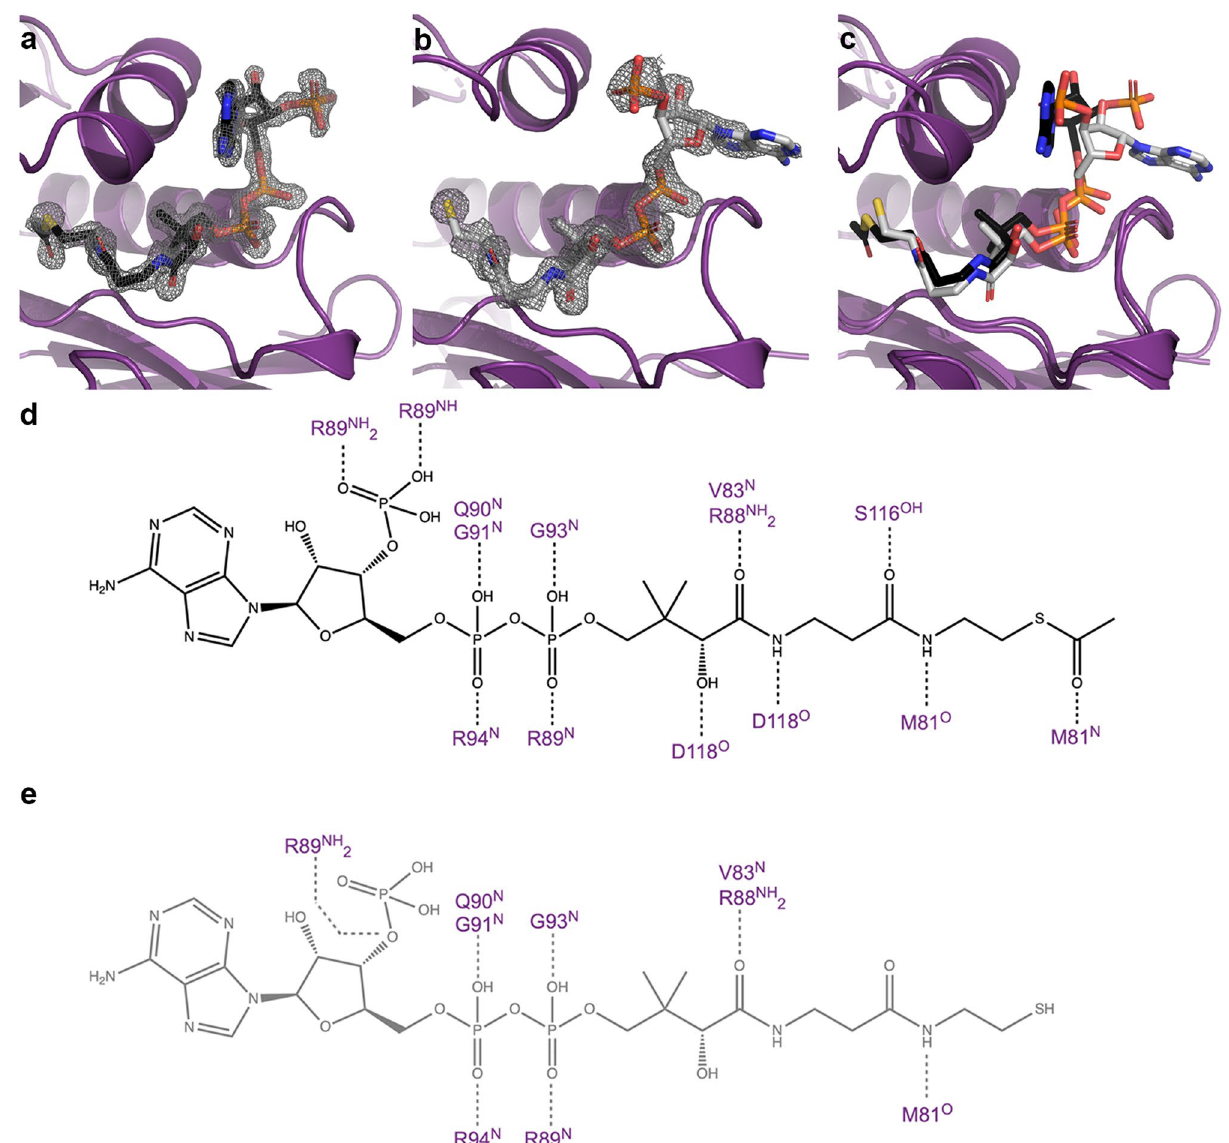
Figure 2. Interactions of Acetyl-CoA and CoA to AAC(2 ′ )-Ia. Panels ( a ) and ( b ) depict representative Fo − Fc discovery maps for ligands acetyl-CoA and CoA from complex structures with amikacin and tobramycin, respectively, at a contour level of 3σ. ( c ) Overlay of AAC(2 ′ )-Ia bound to acetyl-CoA and CoA, same color scheme as panels ( a ) and ( b ). Hydrogen bond interactions between AAC(2 ′ )-Ia and ( d ) acetyl-CoA (black), ( e ) CoA